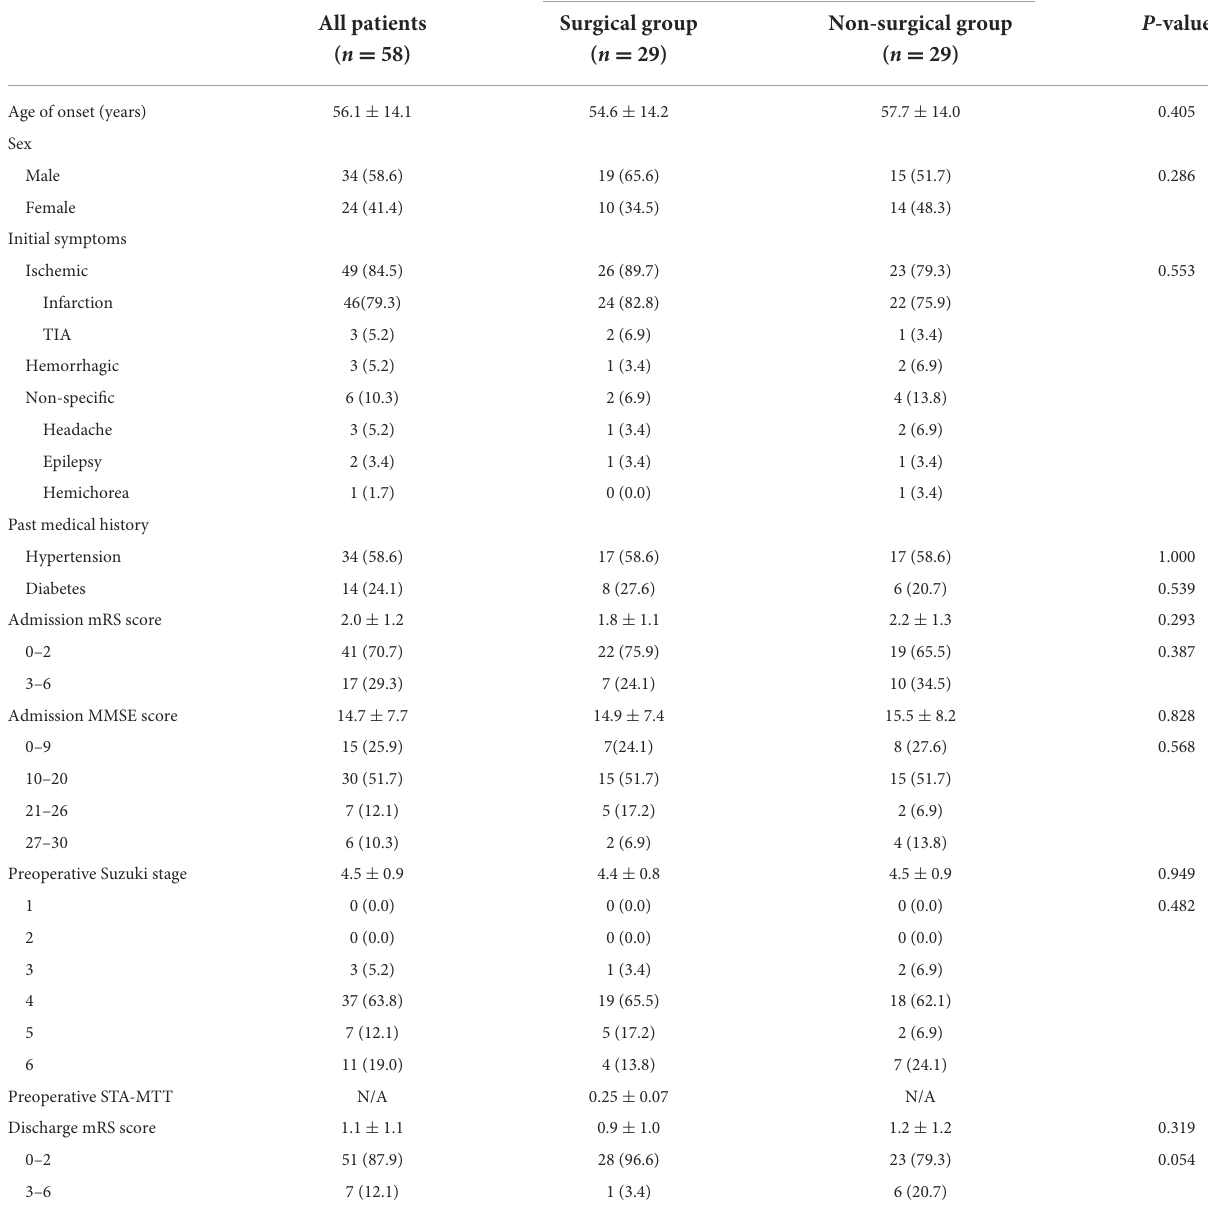
TABLE 4 Comparison of patient characteristics in the surgical and non-surgical groups after propensity-score matching. Characteristics Treatment modalities All patients Surgical